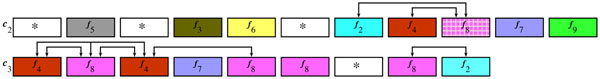
Example of a weak bond among δ-syntenies considering family f8: {(9, f8)c2} is the witness of a weak bond between the δ-syntenies {f8, f2} and {f4, f8}. Colors indicate the homology relationship. Connections indicate the relevant δ—clusters. Crossed box indicates the witness of a weak bond.